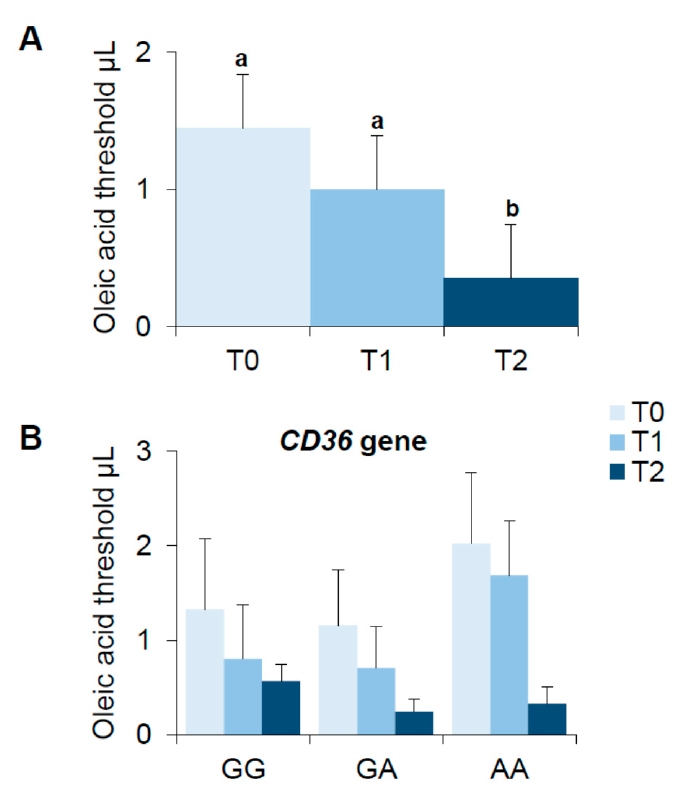
Figure 3. Means ( ± SEM) values of the oleic acid threshold ( µ L) determined before (T0), 1 month (T1) and 6 months (T2) after bariatric surgery ( A ). The same data are shown for each genotype of the rs1761667 (A/G) polymorphism of CD36 gene (genotypes GG: n = 14; genotypes GA: n = 23; genotypes AA: n = 14) ( B ). ( n = 51). Different letters indicate a significant difference ( p ≤ 0.043, Fisher’s test LSD subsequent repeated measures ANOVA).